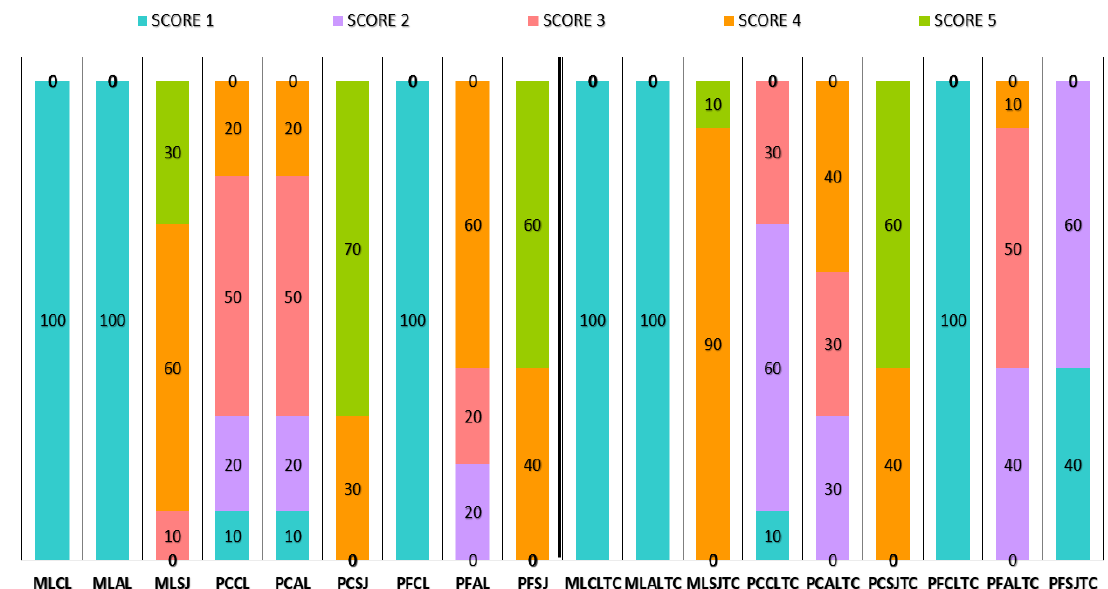
Figure 4. Weibull stress distribution graphs (ln/ln plots) of the various treatments per material. The slope of each graph ( vs y axis) indicates the Weibull scale (m), while the intersection of the graph with the x axis indicates the Weibull modulus (σ ο , 63.2% fracture probability). ( a ) ML: Multilink Automix, ( b ) PC: PermaCem 2.0, ( c ) PF: Panavia F 2.0, CL: Control, AL: Alumina, SJ: Sil-Jet, TC: Thermal-cycling.